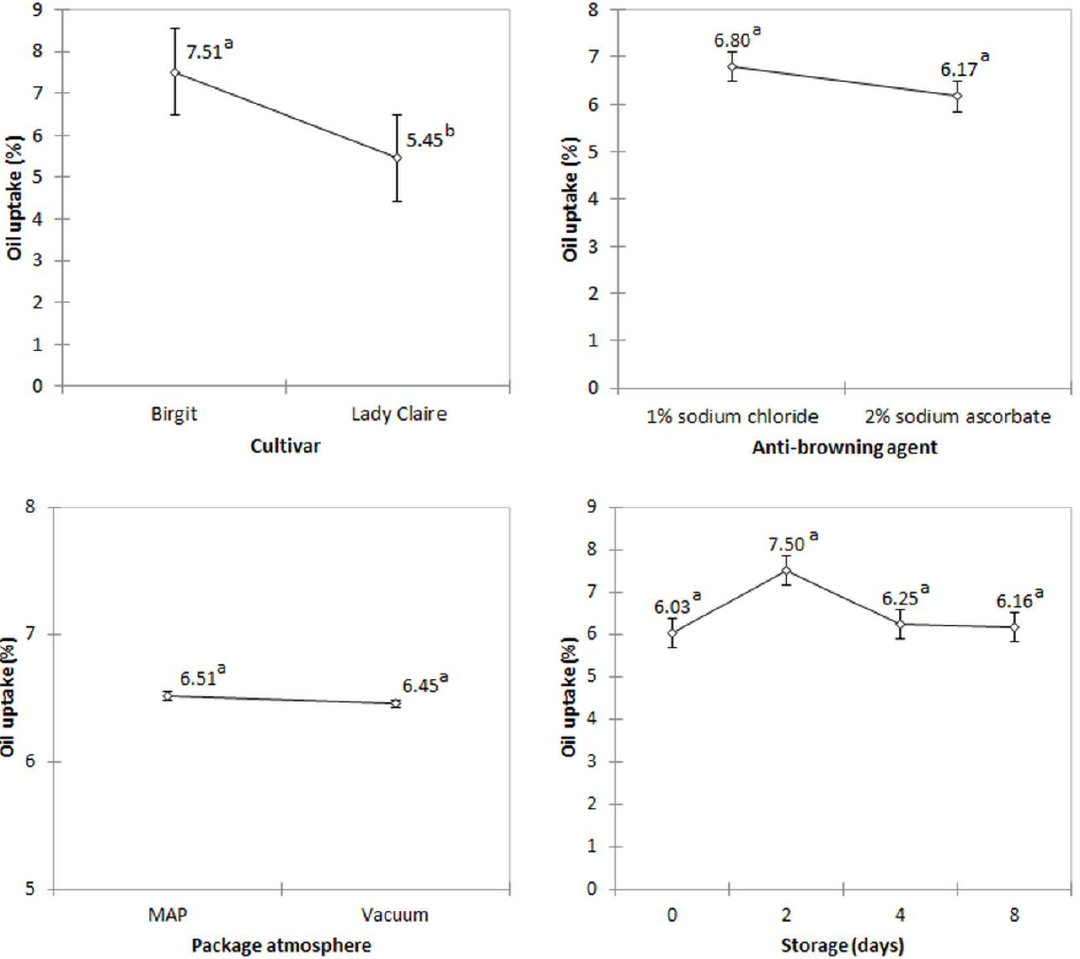
Figure 1. Oil uptake in fried fresh-cut potato as affected by cultivar, anti-browning agent, packaging and storage duration. Results are expressed as mean ± SE of n = 16 for cultivars, anti-browning agents, package atmospheres and n = 8 for days. Values with different letters are statistically different at p ≤ 0.05.